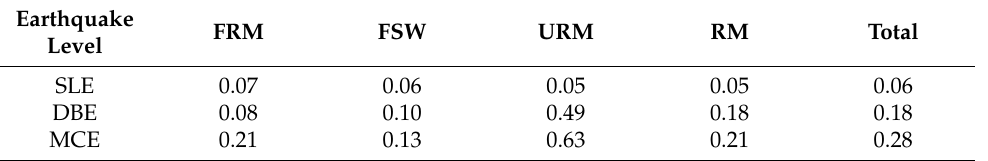
Table 4. Median of average BCR ’ of each structural type under earthquakes.